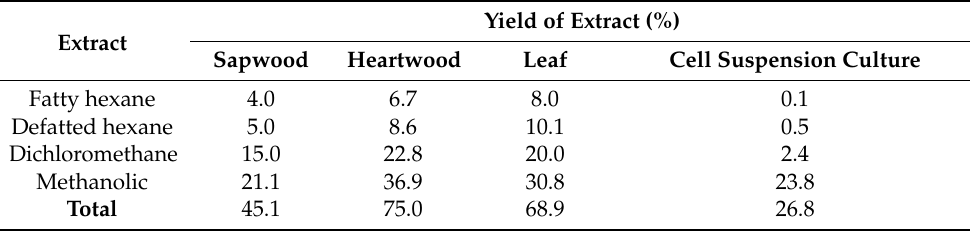
Table 2. Yields of different solvent extraction of intact plant and cell suspension culture of Eysenhard- tia platycarpa . Yield of Extract (%) Extract Sapwood